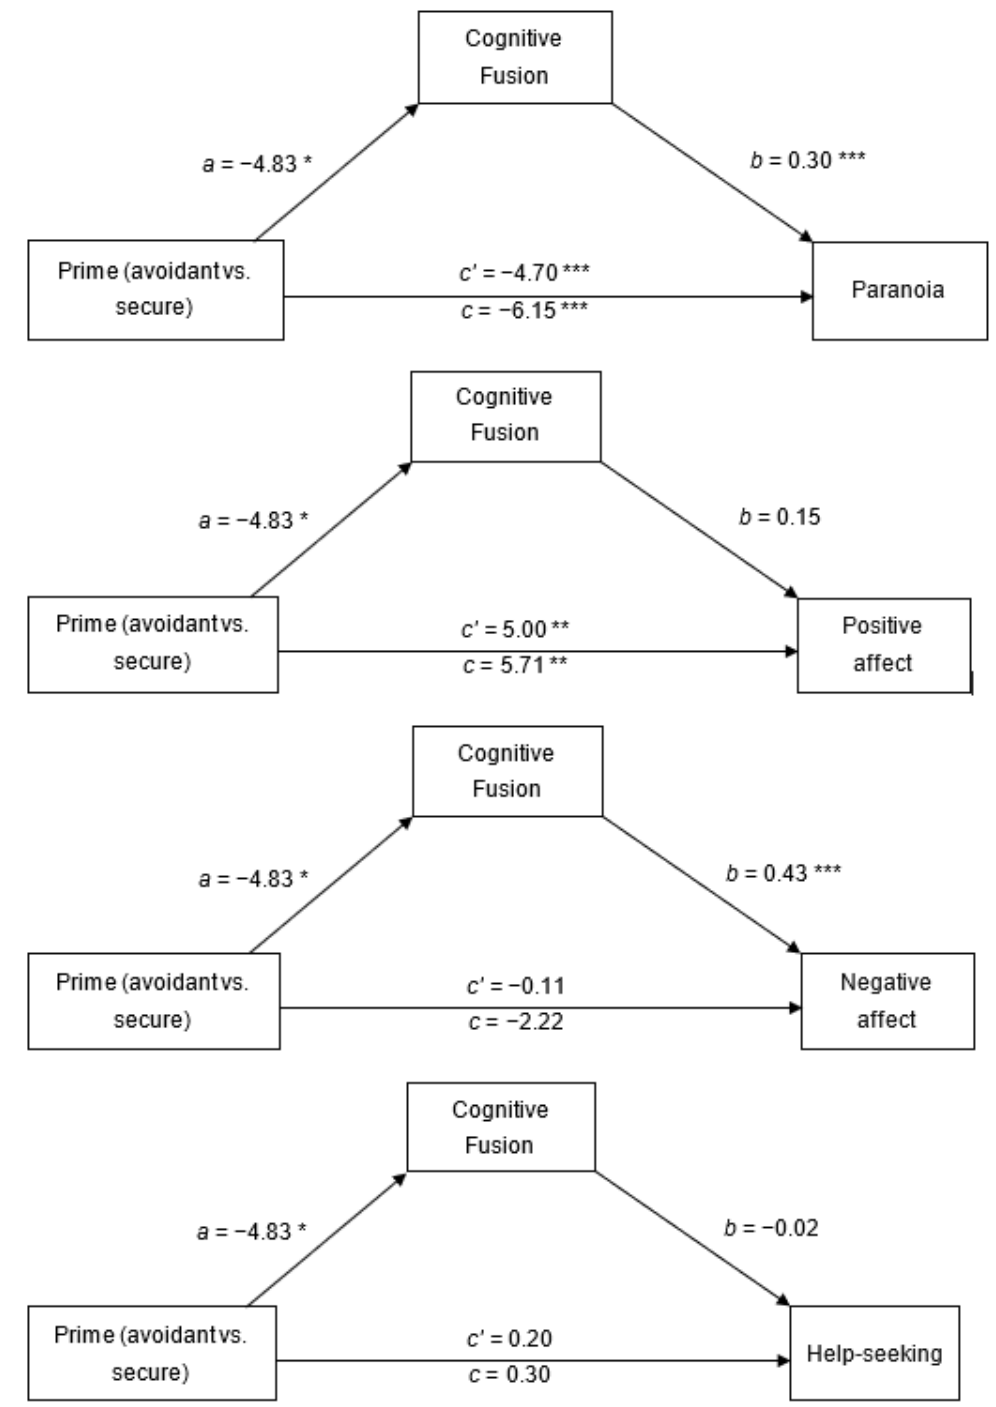
Figure 3. Mediation effects of secure vs. avoidant primes on paranoia, affect and help seeking via cognitive fusion. Note: c ’ = direct effect; c = total effect; estimated path coefficients are unstandardized. * p < 0.05. ** p < 0.01. *** p < 0.001.